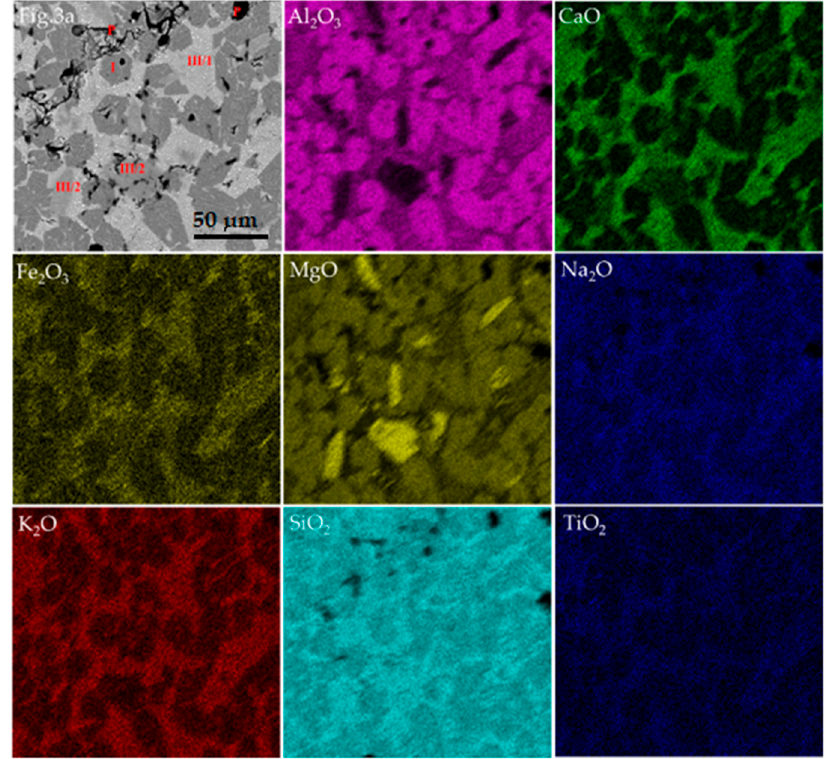
Figure 4. Maps of the elemental oxides’ concentration (%) in various phases.